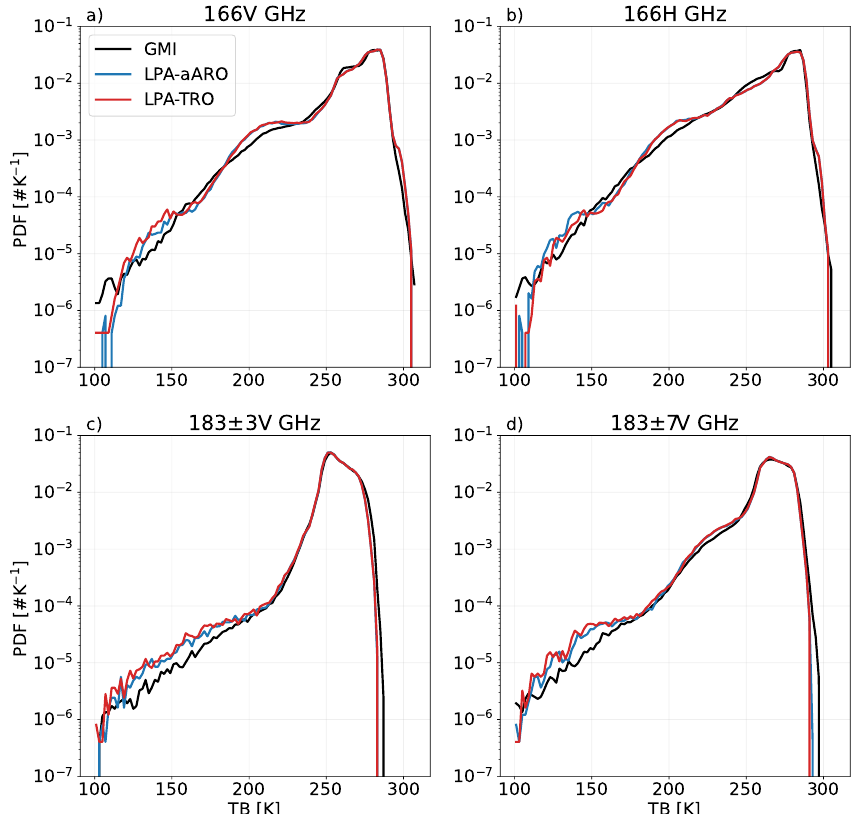
Figure 7. ( a – d ) The distribution of TBs for all high-frequency channels of GMI. The simulations (from January 2009) were based on large plate aggregate. The black curve represents the GMI observations (from January